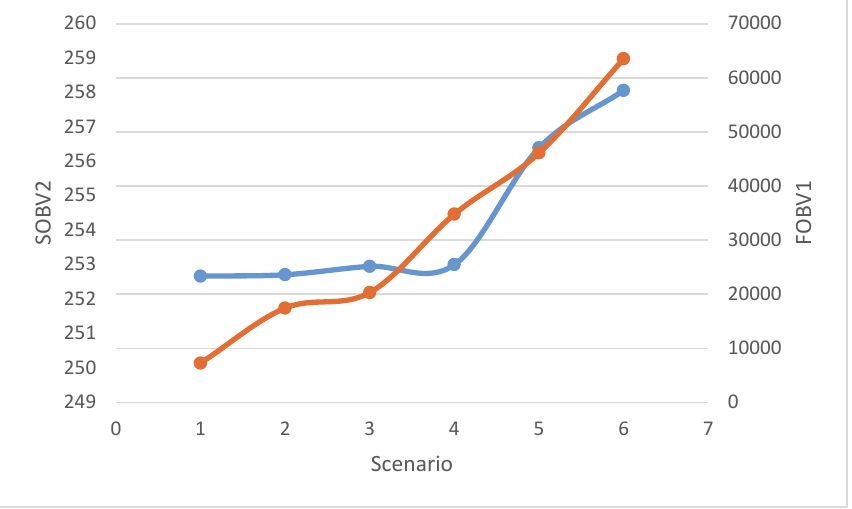
Fig. 8 . Changes in the value of the first and second objective functions in certain and uncertain conditions